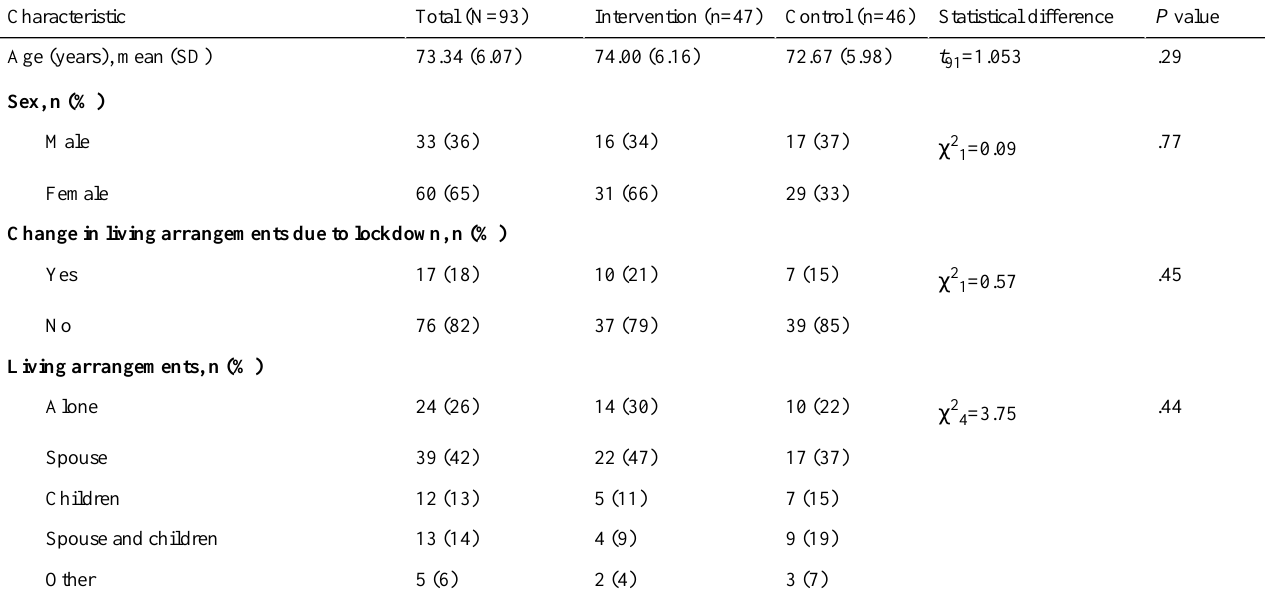
Table 1. Sample characteristics and differences between the intervention and control groups regarding demographic characteristics and living